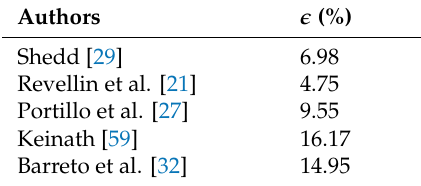
Table 10. Mean absolute error between the new correlation and each database for microchannel tested.